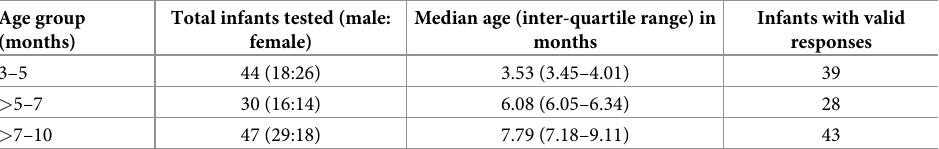
Table 1. Distribution of infants